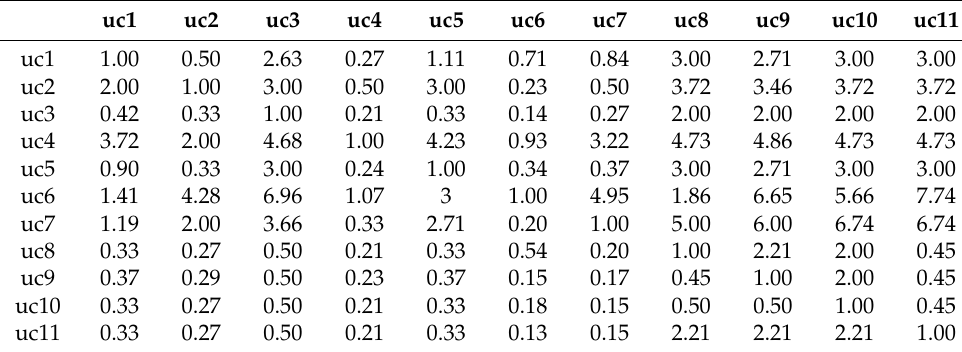
Table 2. Pair-wise comparison matrix of the sub-criteria of usability.